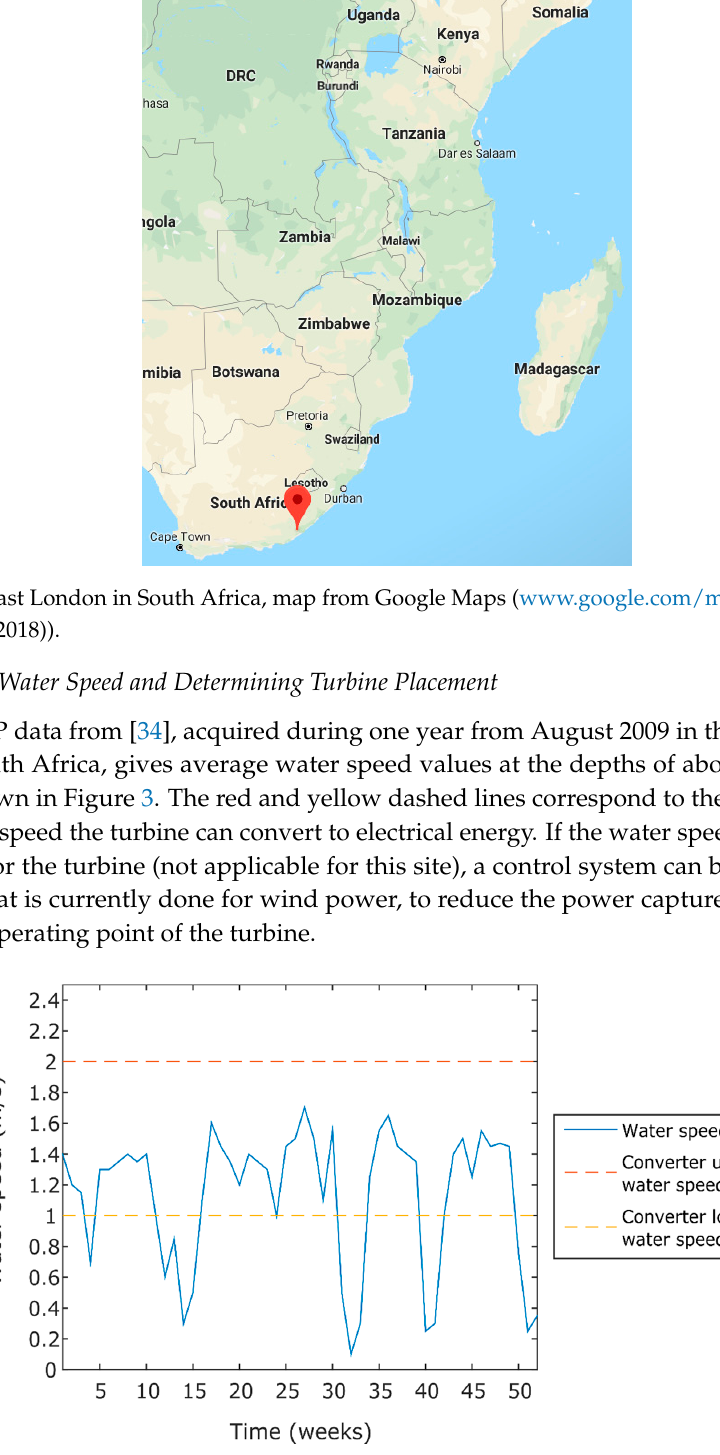
Figure 3. One year of data (starting from August) on the marine current water speeds [m/s] for north East London, South Africa, is shown, divided in weeks, presented previously in [34]. The maximum and minimum values for the Uppsala marine current converter are highlighted, showing a velocity band where power can be produced.